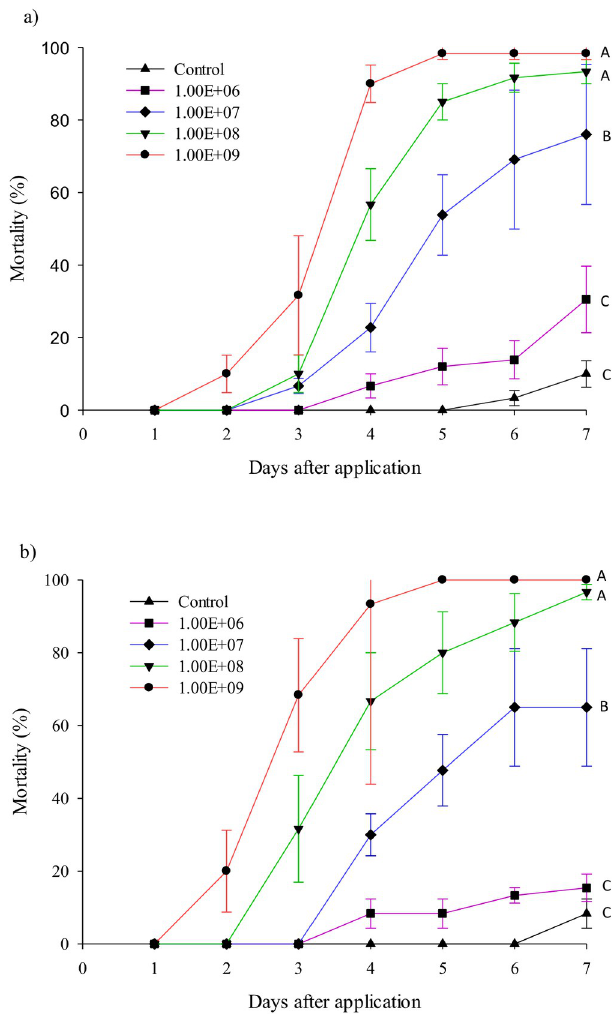
Fig 3. Cumulative pathogenicity of Metarhizium anisopliae at different concentrations of pure conidia to adults (a) and third instar nymphs (b) of Thaumastocoris peregrinus (Hemiptera: Thaumastocoridae) seven days after its application. Means followed by the same capital letters are similar by the Tukey-Kramer test at the 5% significance level.